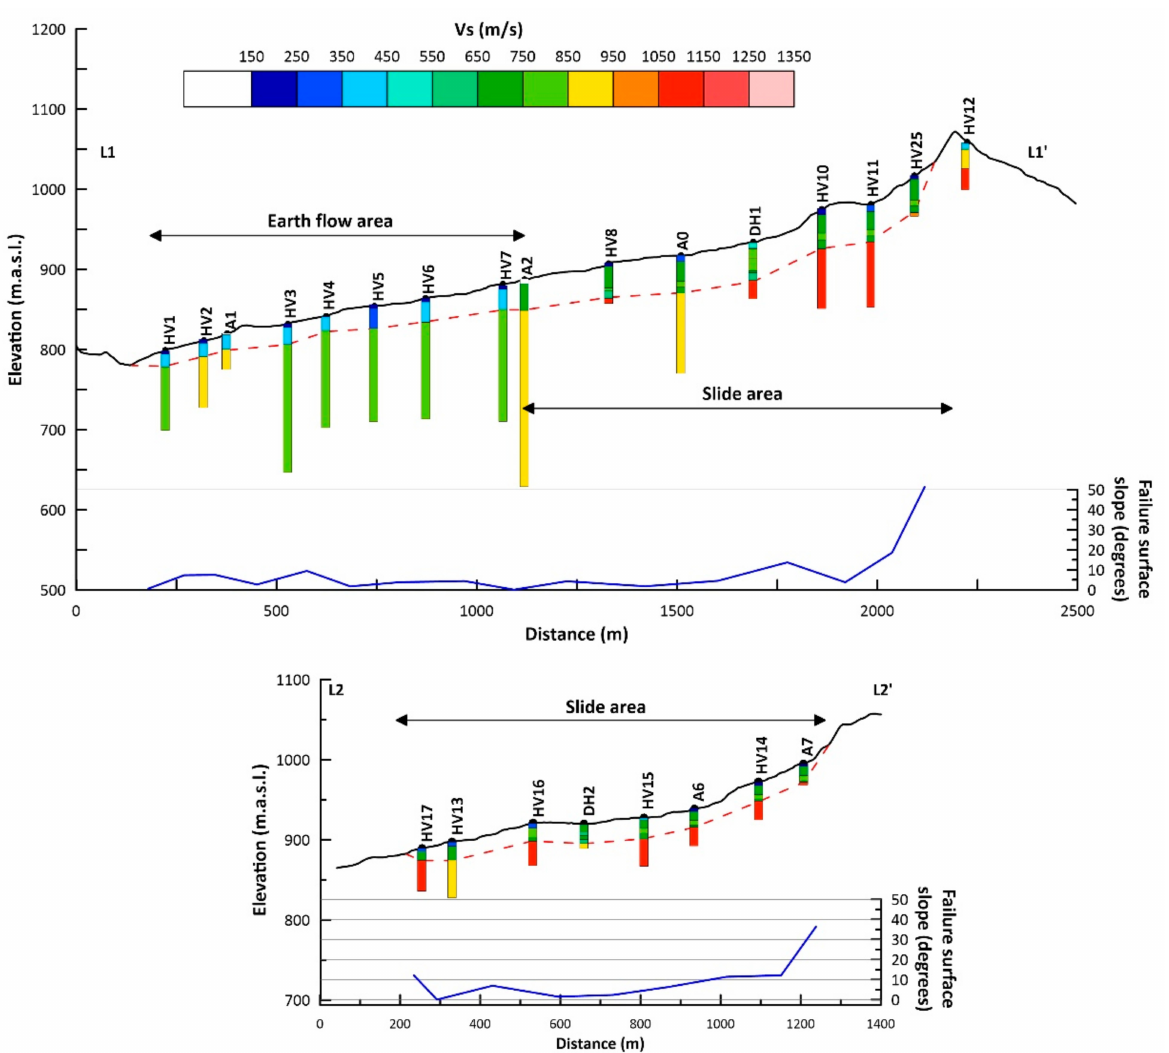
Figure 9. Longitudinal cross sections of the landslide. See Figure 3 for location of sections. The dashed red line shows the location of the failure